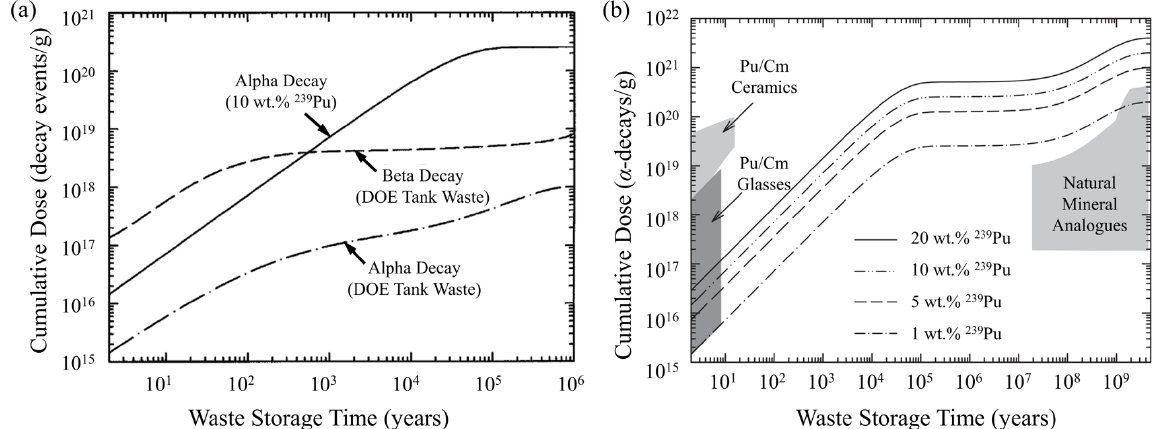
Figure 3. Cumulative Dose as a function of waste storage time. ( a ) β -decay and α -decay events per gram for a multiphase ceramics or glass-ceramics containing DOE high-level tank waste. Additionally shown is the cumulative number of α -decay events per gram for a ceramic containing 10 wt.% 239 Pu. ( b ) Cumulative α -decay dose as a function of time for different 239 Pu concentrations. Additionally, the dose-time ranges for available data from Pu/Cm containing glasses and ceramics, as well as for natural mineral analogues are also shown. ( a ) Reproduced with permission from Reference [29], Copyright © Springer Nature 2011; ( b ) Reproduced with permission from Reference [7], Copyright © Springer Nature 2010.